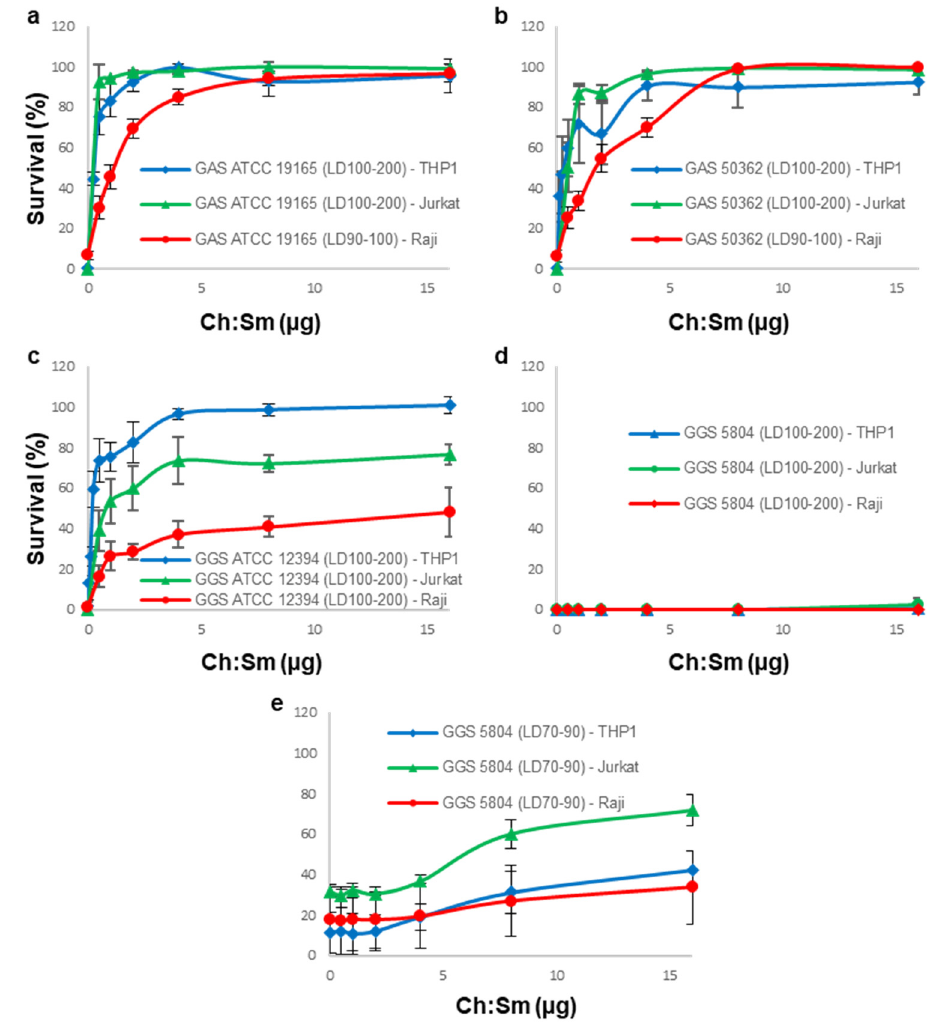
Figure 2. Neutralization of the cytotoxins secreted by GAS and GGS by cholesterol-containing liposomes. Ch:Sm-liposomes (Ch = 66 mol/%) completely neutralized cytolytic activities of GAS supernatants (LD >90 ) towards all immune cell lines used in the current study ( a , b ). Ch:Sm-liposomes provided full protection to THP-1 cells against the GGS ATCC 12394 supernatant (LD >90 ), but only partial protection for Jurkat and Raji cells. Protection levels differ significantly between all cell types, p -values < 0.0005 ( c ). Ch:Sm-liposomes provided no protection against the GGS 5804 supernatant (LD >90 ) for any cell type ( d ). Ch:Sm-liposomes provided partial protection against the GGS 5804 supernatant for THP-1 cells (~35% of ~LD 90 , p -value < 0.005), Jurkat cells (~40% of ~LD 70 , p -value < 0.008), and Raji cells (~15% of ~LD 85 , p -value < 0.005) ( e ). Error bars = mean ± SD; N ≥ 3.